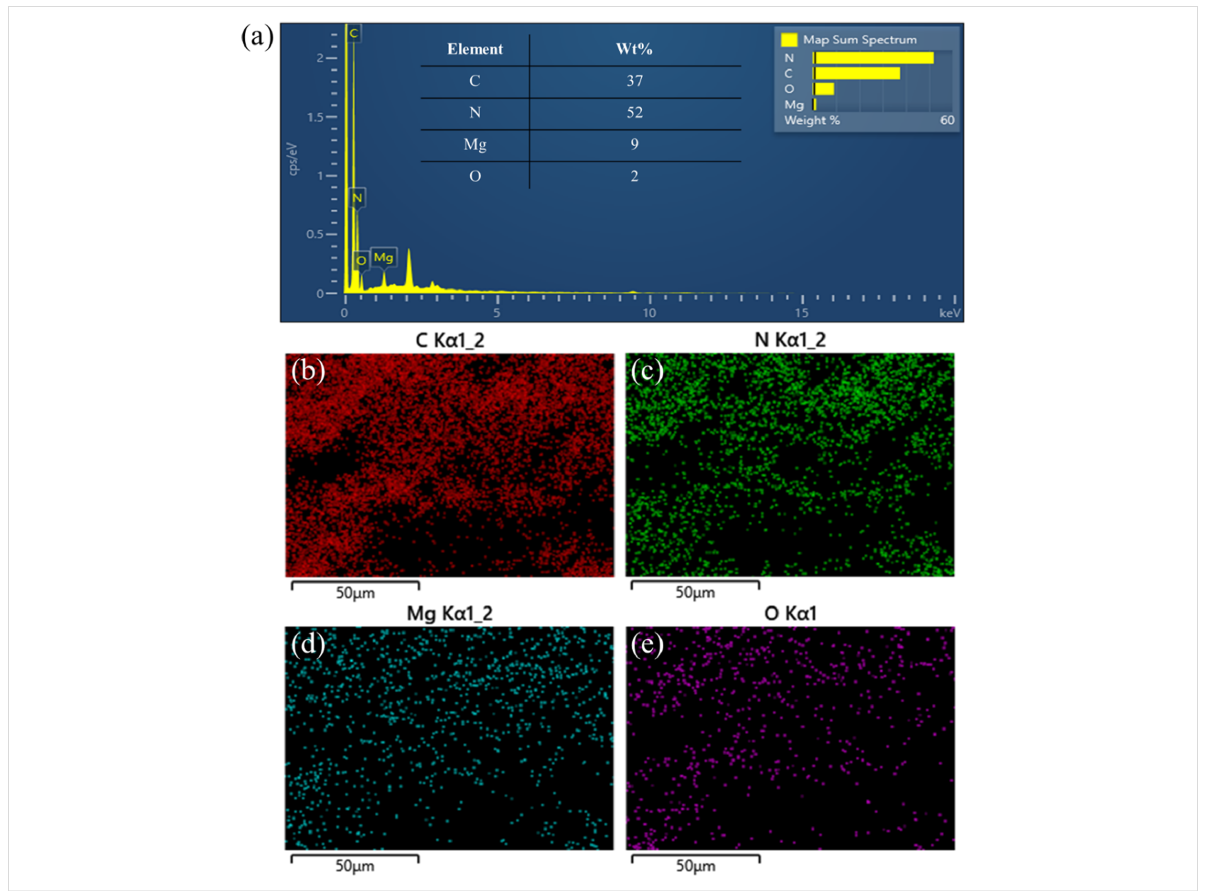
Figure 6: (a) Elemental composition and (b–e) EDS mappings of 3% MgO@g-C 3 N 4 .